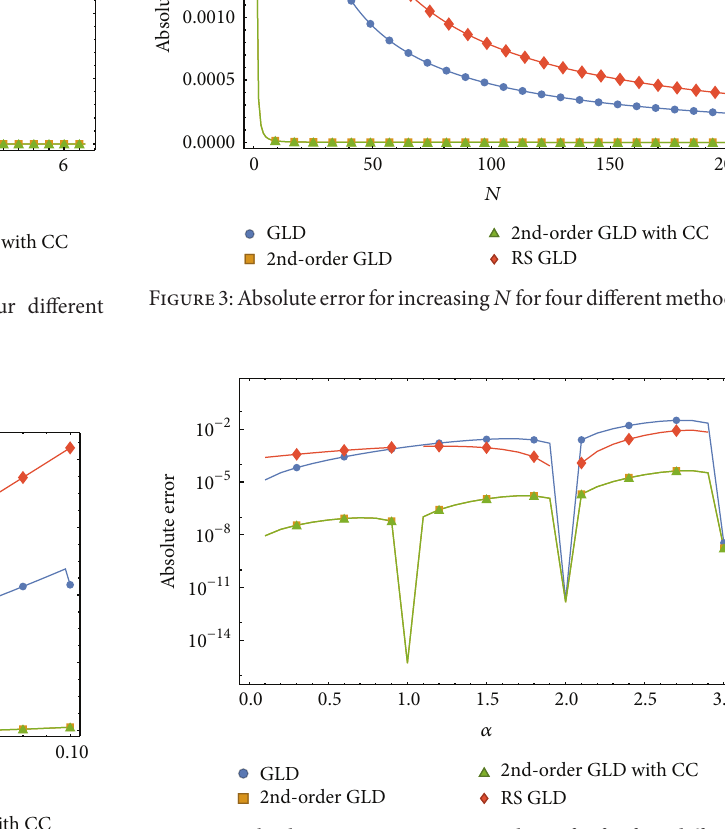
Figure 4: Absolute error over varying values of 𝛼 for four different